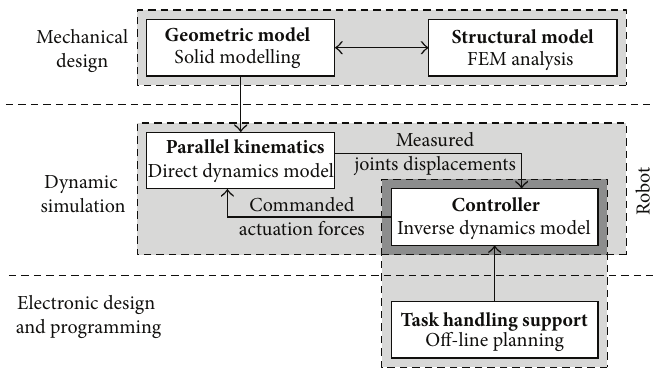
Figure 7: Integrated virtual prototyping environment for PKM’s analysis and design.